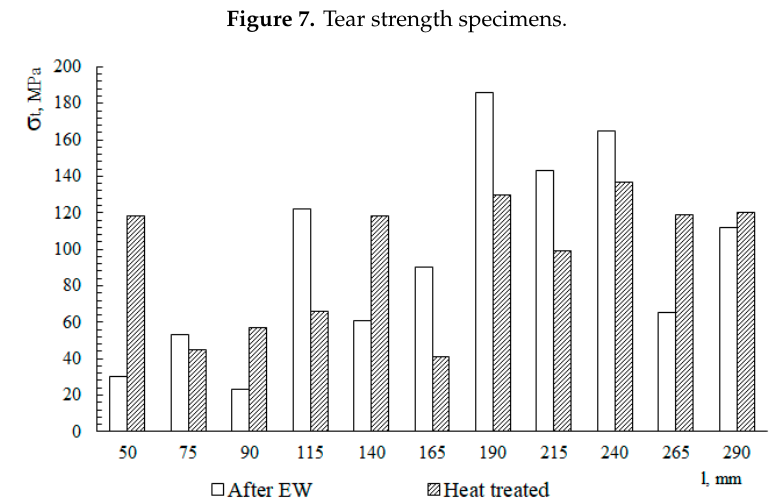
Figure 8. The tear strength values distribution along the bimetal sheet.